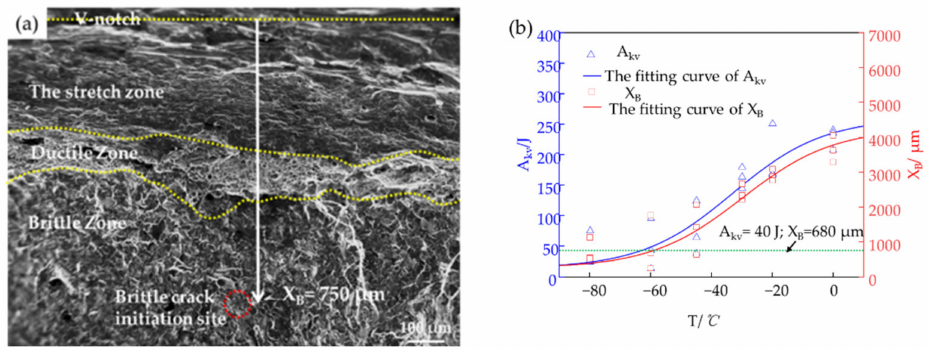
Figure 9. ( a ) the low magnification of the initiation site; ( b ) the A kv and the corresponding X B values of three samples at each temperature.